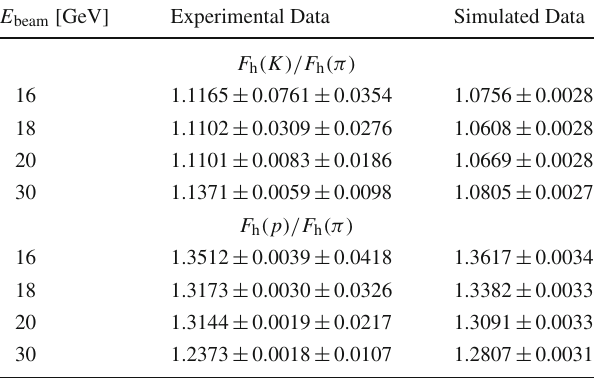
Table10 Valuesoftheratios F h ( K )/ F h (π) and F h ( p )/ F h (π) obtained using experimental and simulated data for the four values of the beam energies E beam . In the case of experimental determinations statistical (first value) and systematic (second value) uncertainties are reported separately. Only statistical uncertainties affect the MC results